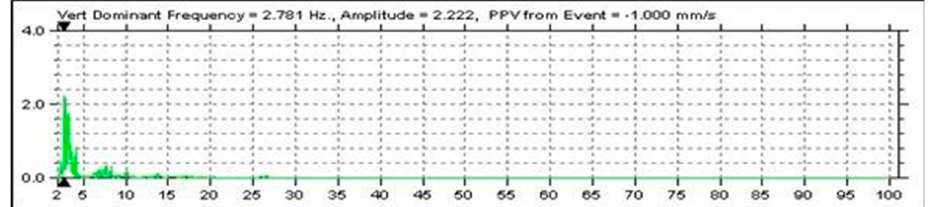
Figure 9. FFT analysis (Blastware Software 10.74- Advanced Module) for vibration measurements.